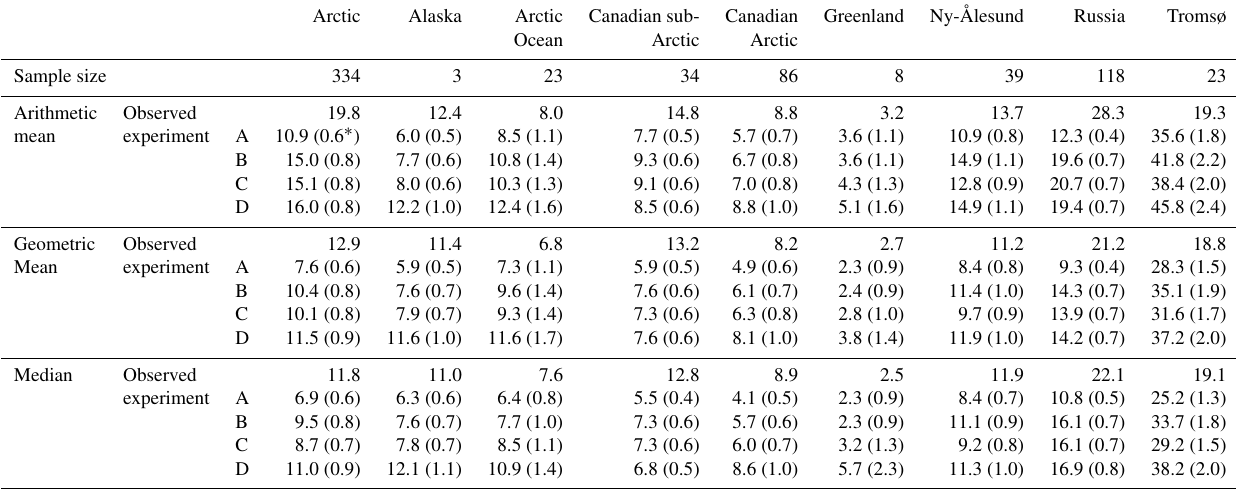
Table 4. Observed and GEOS-Chem simulated BC concentration in snow in the Arctic (ngg − 1 ; see Fig. 1).